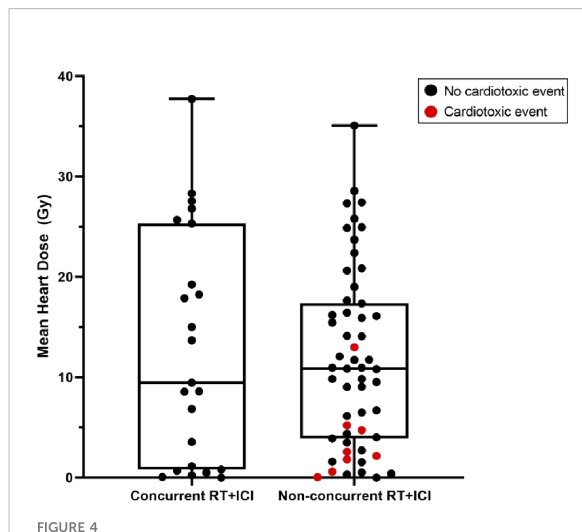
FIGURE 4 Boxandwhiskerplotsofmeanheartdoseofsubjectswhoreceived radiotherapyconcurrentlywithICI(concurrentRT+ICI)versusnot (non-concurrentRT+ICI).Eachpointrepresentsapatient,plotted againsttherange,interquartilerange,andmedian.Therewasno signi fi cantdifferenceinmeanheartdosebetweenthegroups(p=0.96).